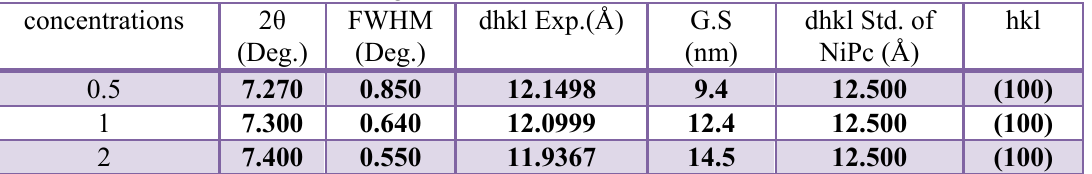
Table 2: Structural parameters viz. inter-planar spacing and crystalline size of NiPcTs:PEDOT:PSS bulk heterojunctions blend thin films.